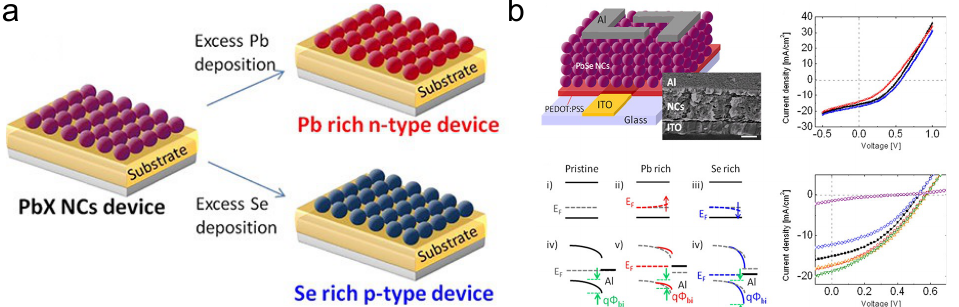
Figure 4. ( a ) Illustration of tuning stoichiometry of PbX CQD. ( b ) Characterization of PbSe CQD solar cells with different stoichiometry. Reprinted with permission from [54]. Copyright 2013 American Chemical